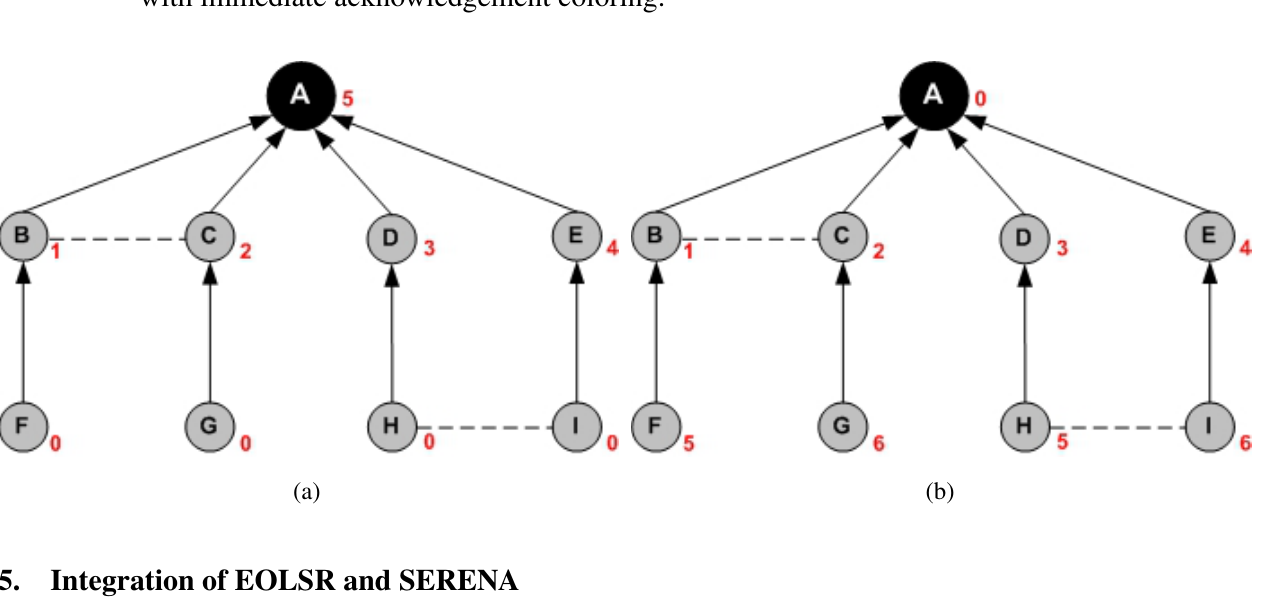
Figure 16. Example of tree coloring: (a) TDMA-ASAP coloring; (b) SERENA with immediate acknowledgement